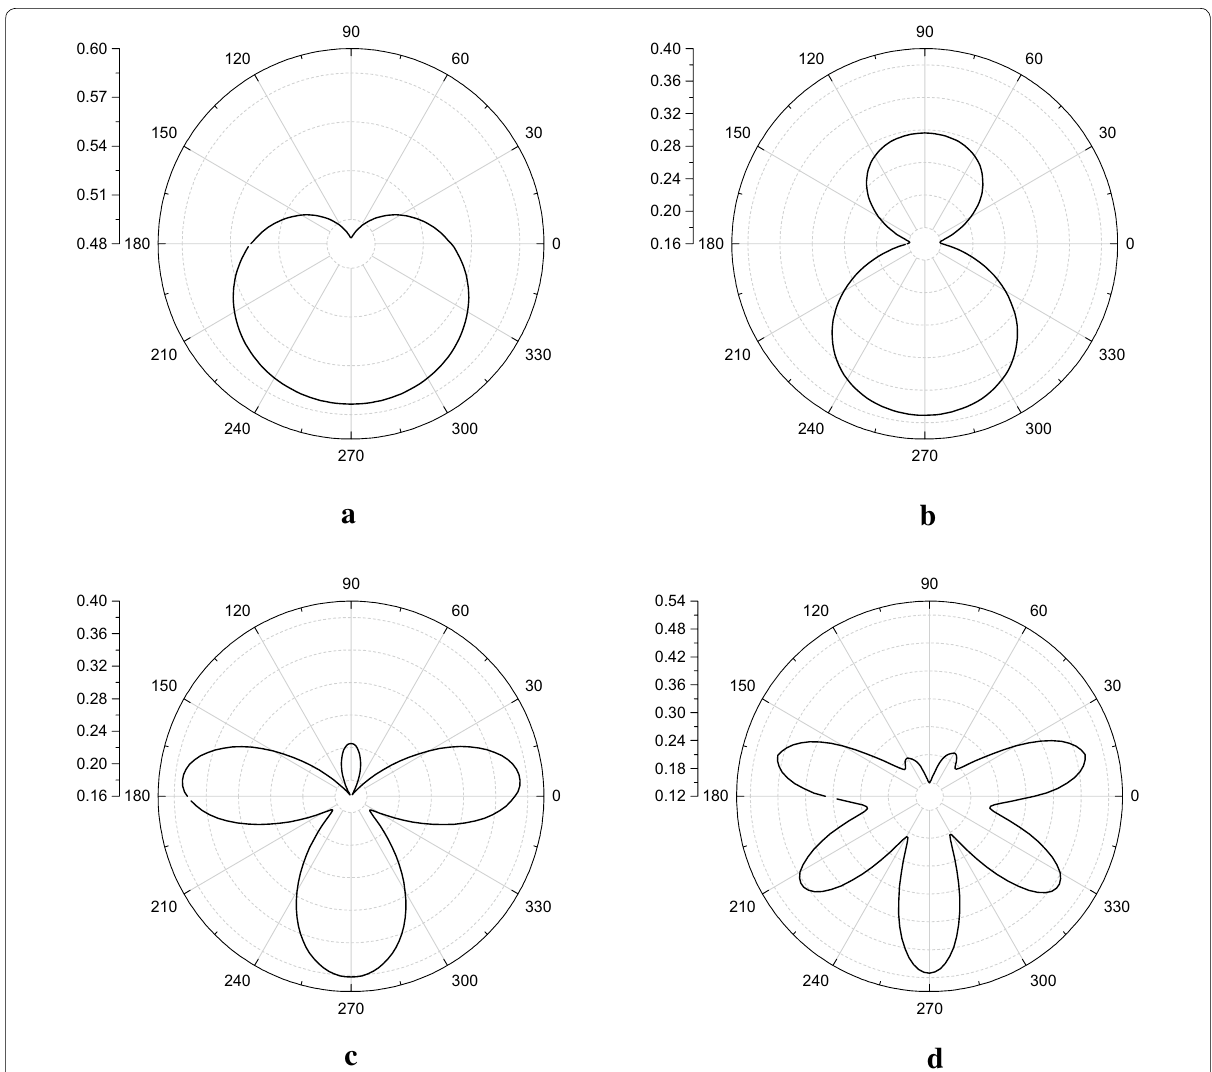
Figure 3 Angular distribution of scattered pressure of array plane wave versus ka ( f = 235 kHz, 850 kHz, 1109 kHz, and 2348 kHz ) incident pressure amplitude is one, array number is 16, array element width is 2.8 mm, and array element interspace is 0.7 mm): a ka = 0.5 , b ka = 1.8 , c ka = 3.0 , and d ka =